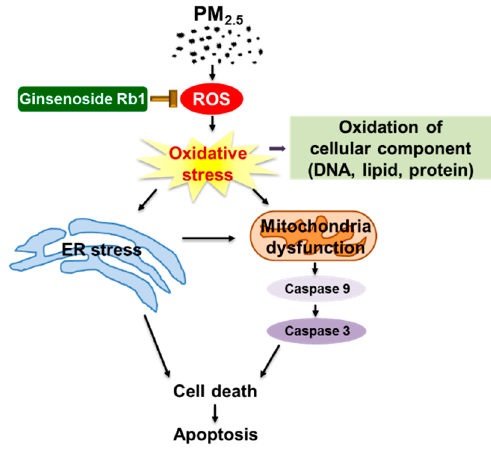
Figure 8. A schematic diagram of the protective effect of ginsenoside Rb1 against PM 2.5 . Ginsenoside Rb1 inhibits PM 2.5 -induced oxidative stress and prevents ER stress generation and mitochondrial dysfunction, thereby protecting cells from PM 2.5 injury.